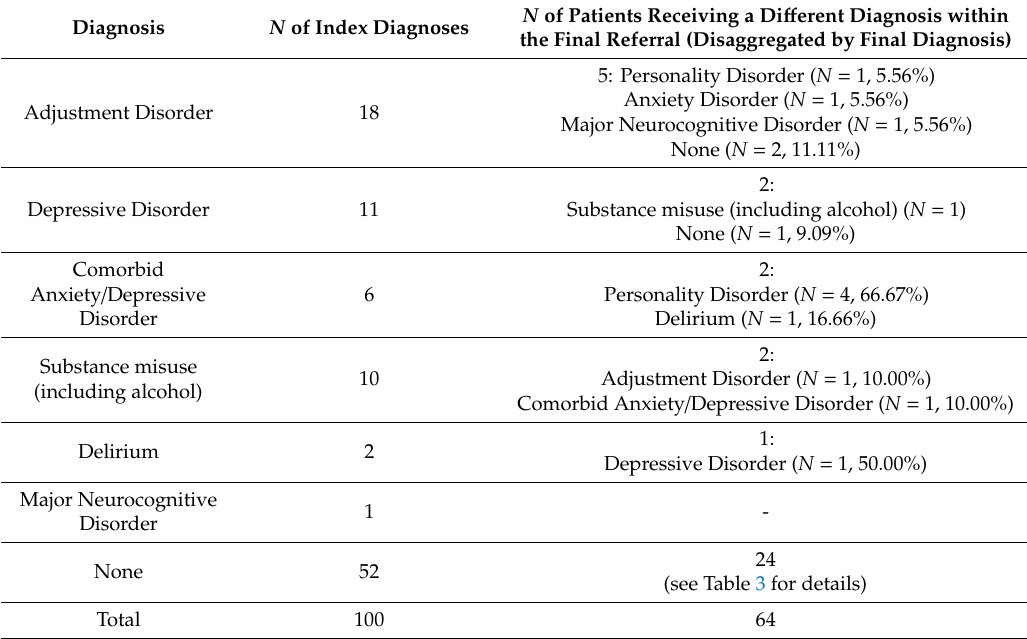
Table 2. Type and number of diagnoses changed within the final referral.